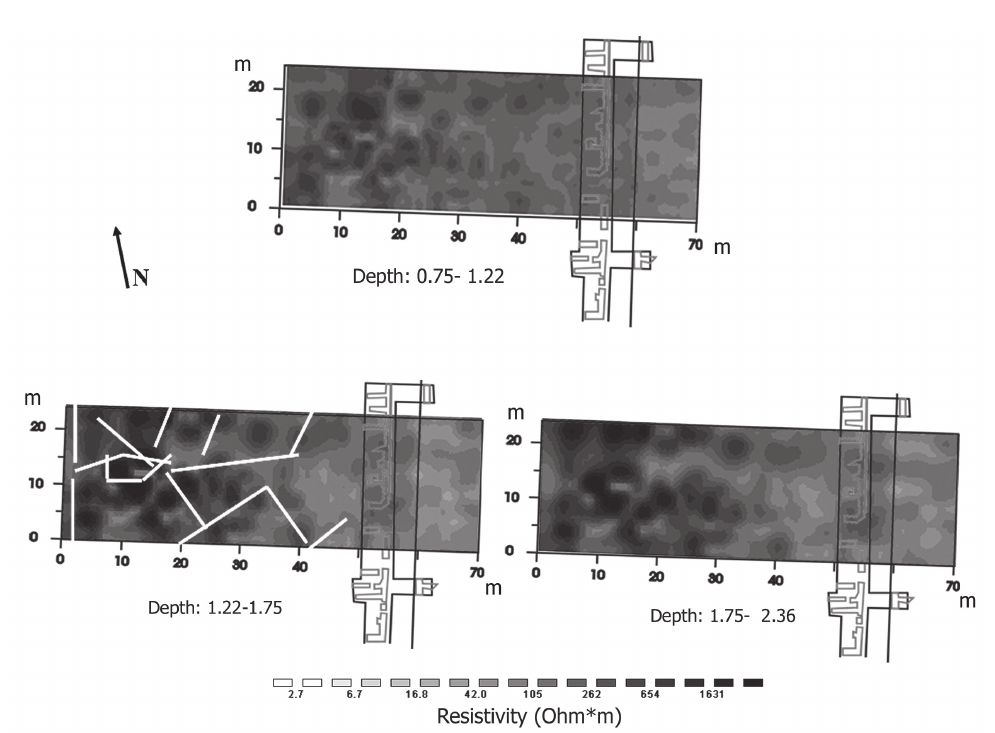
Fig. 4. Results of the inversion of geoelectrical data at depths ranging from 0.35 to 2.36 m. They are concentrated in the western sector of the map. The main resistivity anomalies are indicated with white bold lines. In the eastern sector SW resistivity anomalies are correlated with the superposition of the structures excavated in the archaeo- logical 1970